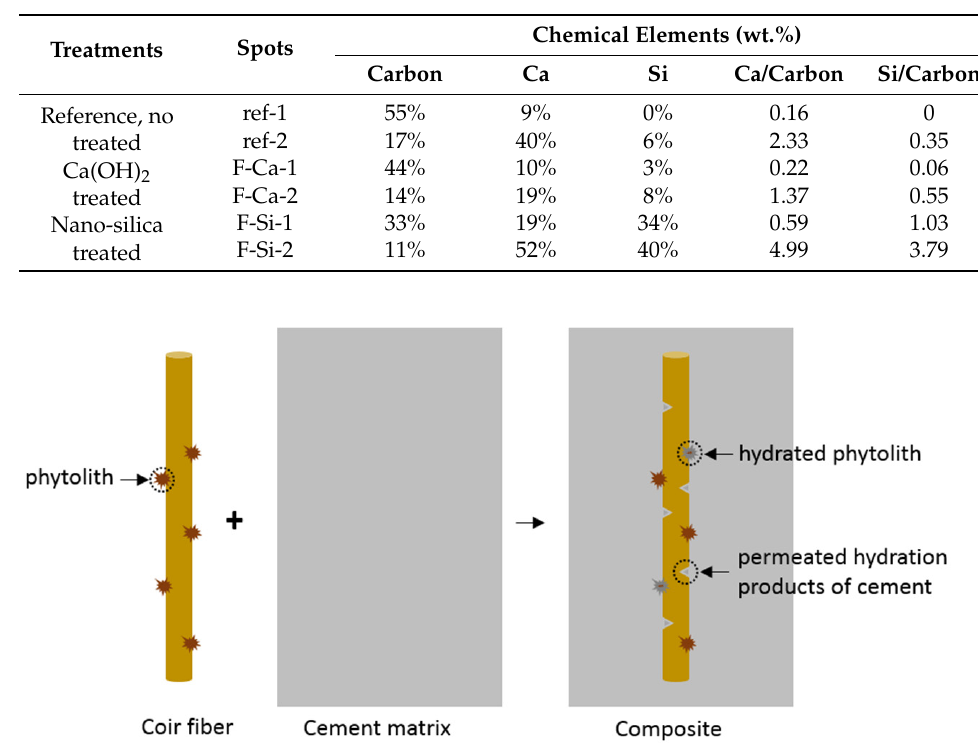
Figure 9. Schematic diagram of the interlocking effect between coir fibers and cement matrix.